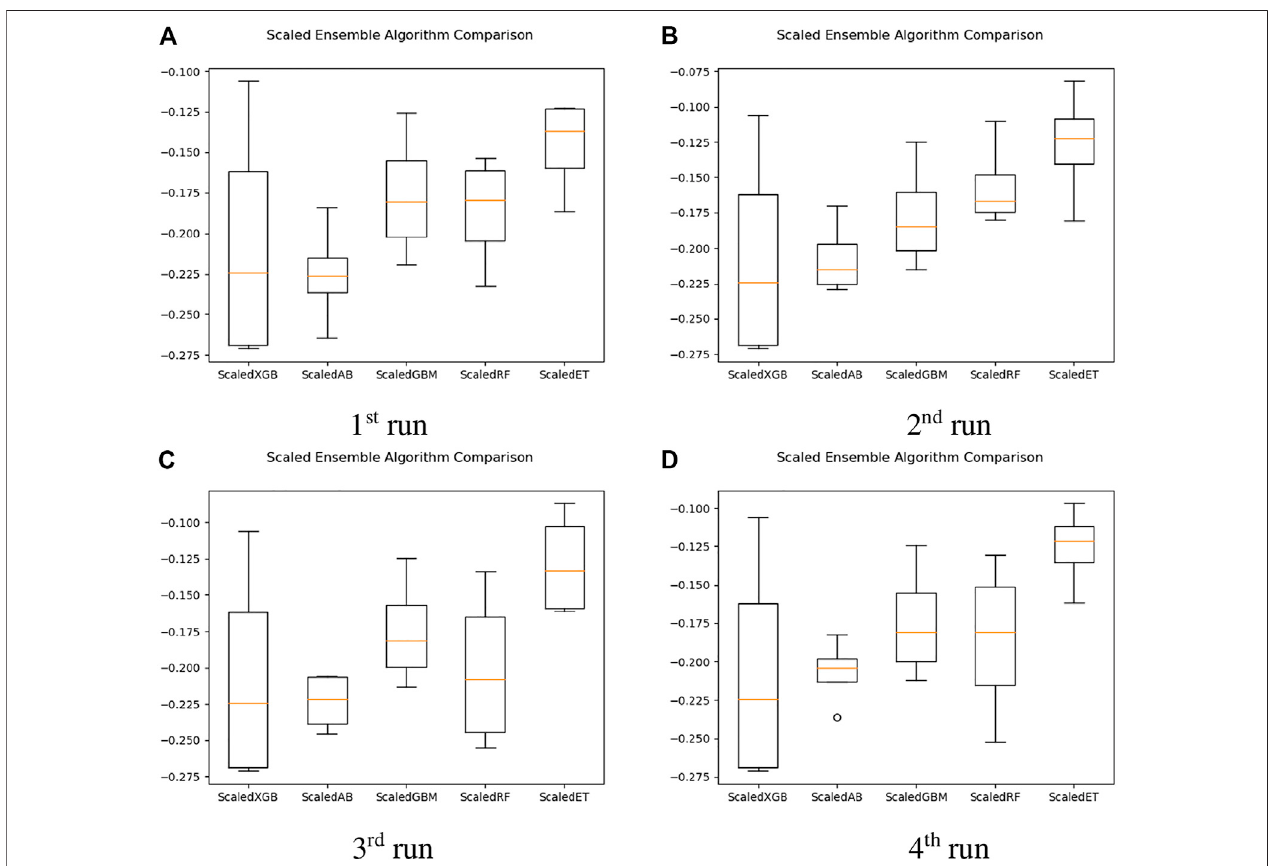
FIGURE 8 | Ensemble models comparison – four runs.